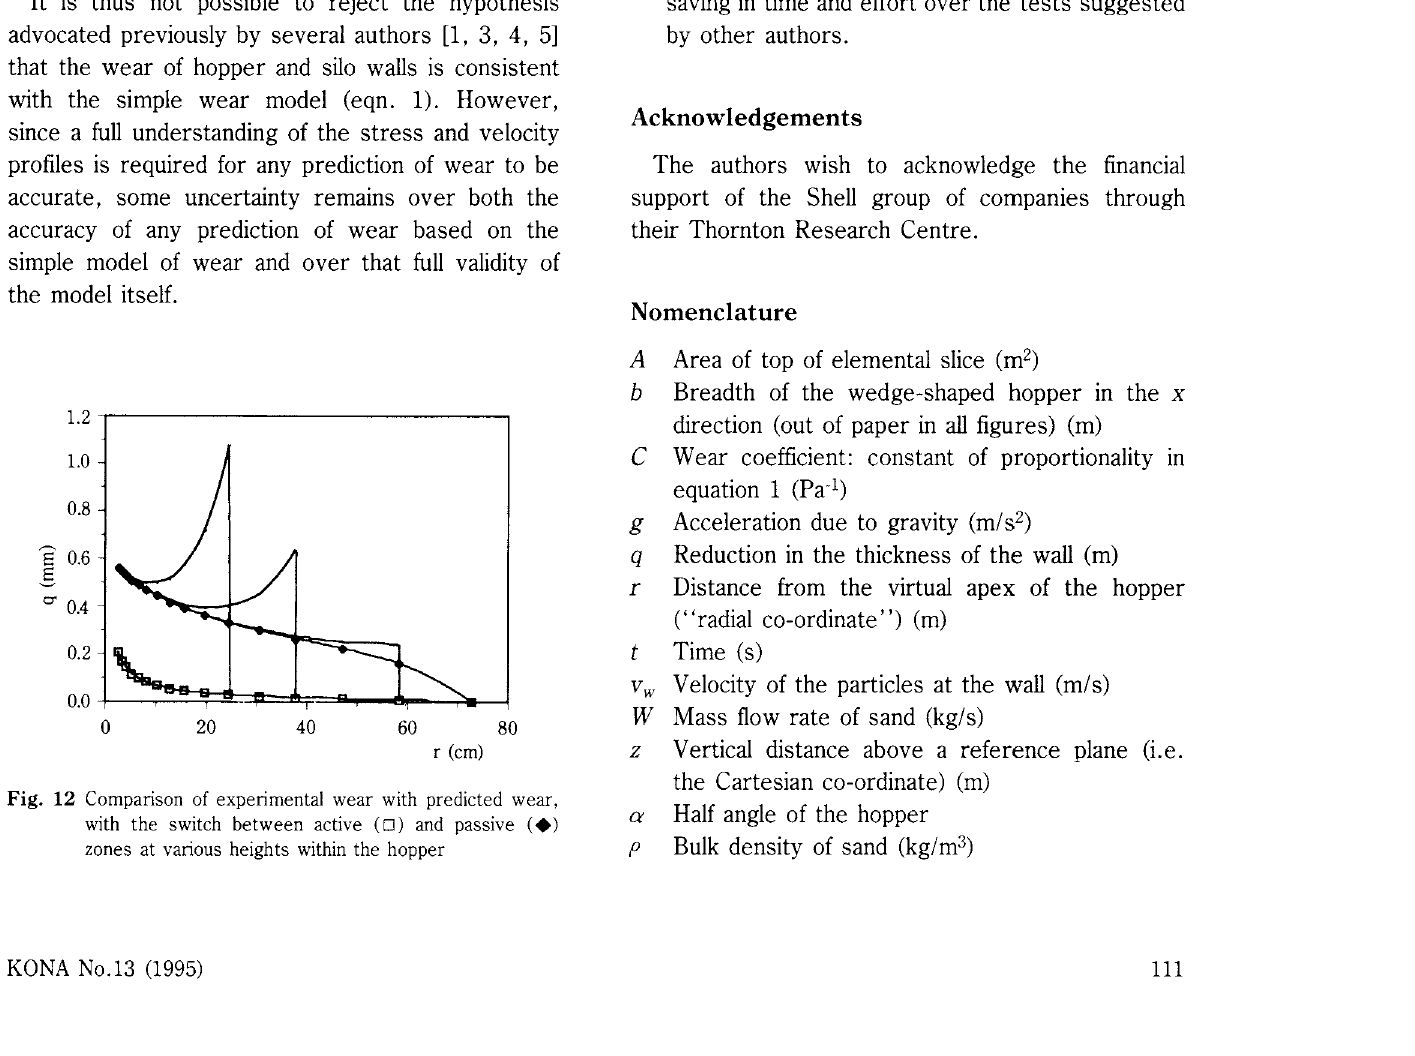
Fig. 12 Comparison of experimental wear with predicted wear, with the switch between active ( 0) and passive ( +) zones at various heights within the hopper